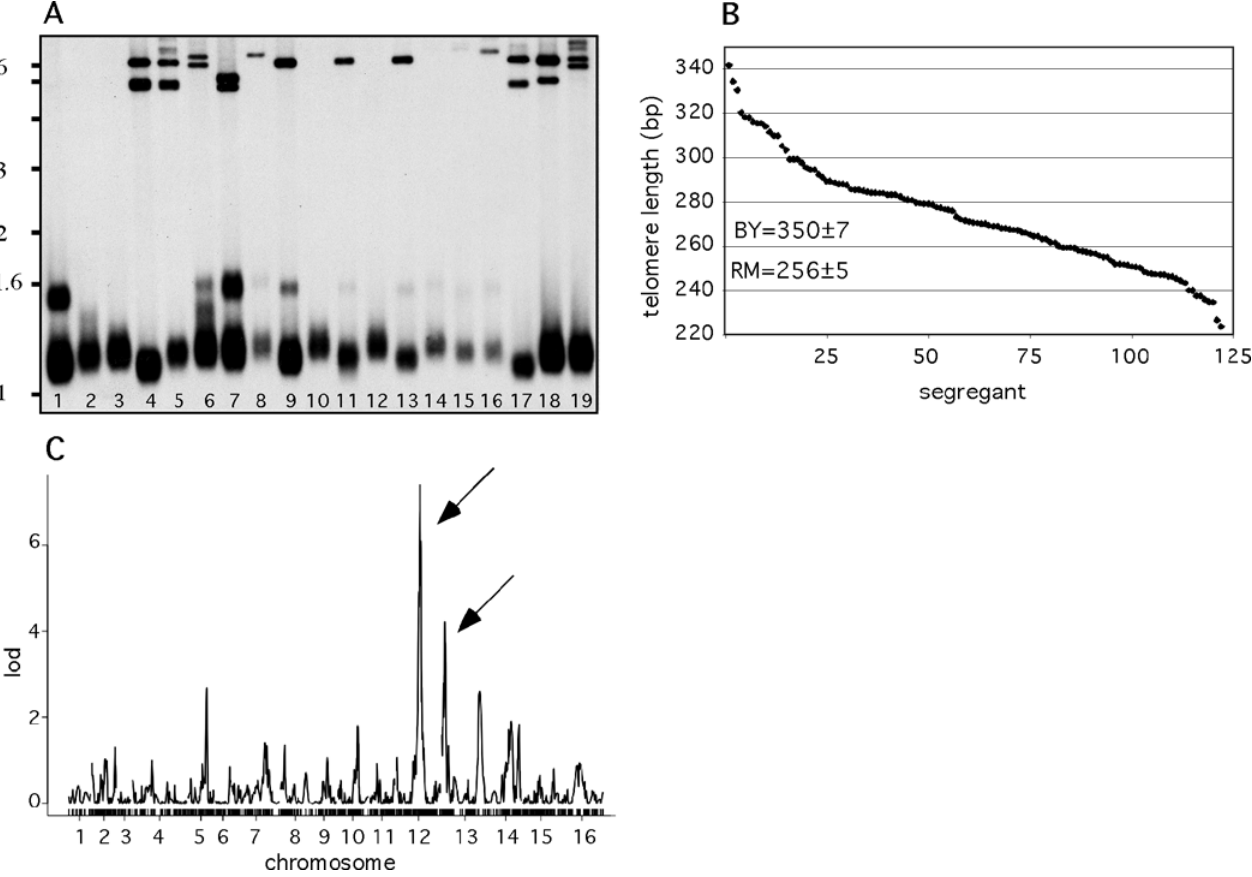
Figure 6. Telomere Length-Analysis in Outbred Yeast Strains (A) Variation of telomere length among natural isolates of S. cerevisiae. Southern blot with terminal restriction fragments from diploid strains (lanes 1– 12, 14) isolated from vineyards, their haploid derivatives (lanes 13, 15–17), and two laboratory strains BY (lane18) and A363A (lane 19). Haploid strains RM5–1 (lane 13) are derived from diploid strain Bb24(4) (lane 9), haploid strain Y55a (lane 15) from diploid strain Y55 (lane 14), haploid strain RM3-1a (lane 16) from diploid strain Bb3(1) (lane 8), and haploid strain RM4–1 (lane 17) from diploid strain Bb24(3) (lane 4). Other diploid strains include Bb26(5) (lane 1), Bb31(2) (lane 2), Bb32 or RM11 (lane 3), PC25A (lane 5), Ba25 (lane 6), Bb2(1) (lane 7), Bb25(6) (lane 10), Bb 25(8) (lane 11), and Bb 26(2) (lane 12). (B) Average telomere length-variation in 122 haploid progeny of a cross between vineyard (RM11-1a, a haploid progeny of diploid RM11) and laboratory (BY) strain. Average telomere length of the progeny is continuously distributed between 222 and 342 bp, consistent with the genetic trait controlled by several loci. The average telomere length in the parents, obtained through three independent measurements, was 350 6 7 and 256 6 5 for BY and RM11, respectively. (C) Genome scan for loci that control telomere length in BY and RM11. The arrows indicate significant loci at Chromosome 12 and Chromosome 13. DOI: 10.1371/journal.pgen.0020035.g006